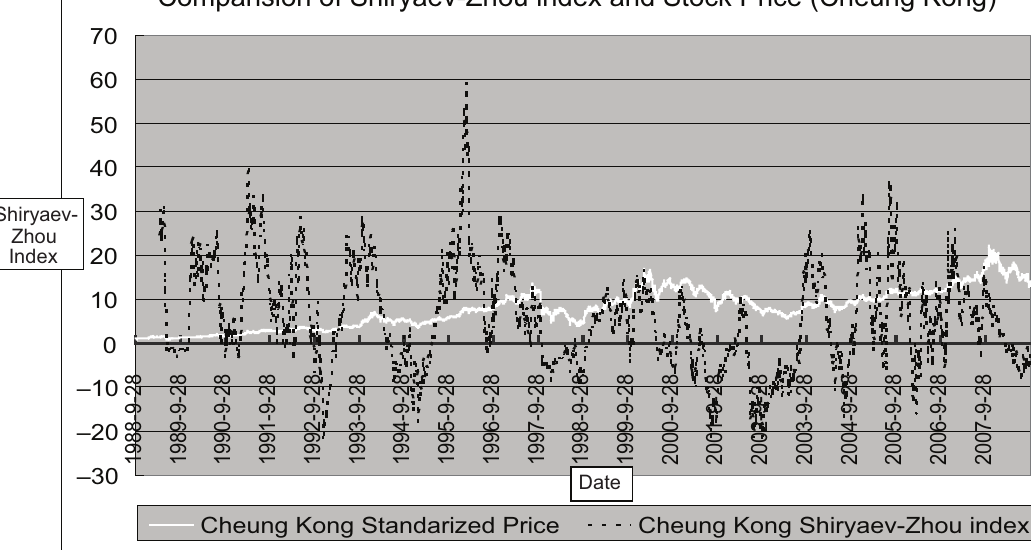
figure 5. Comparision of shiryaev-Zhou index and stock Price of Cheung Kong